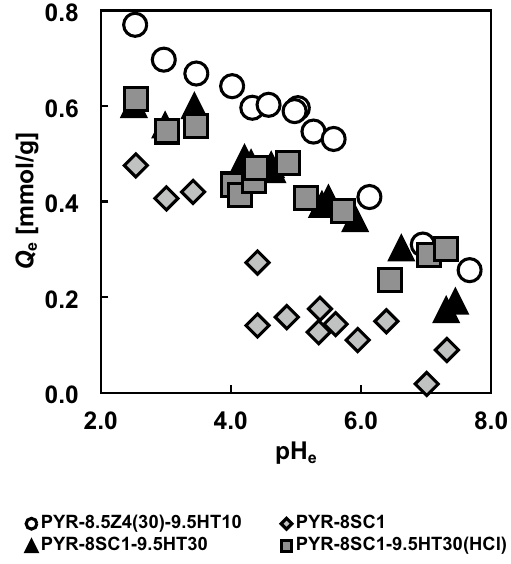
Fig. 5 Influence of solution pH